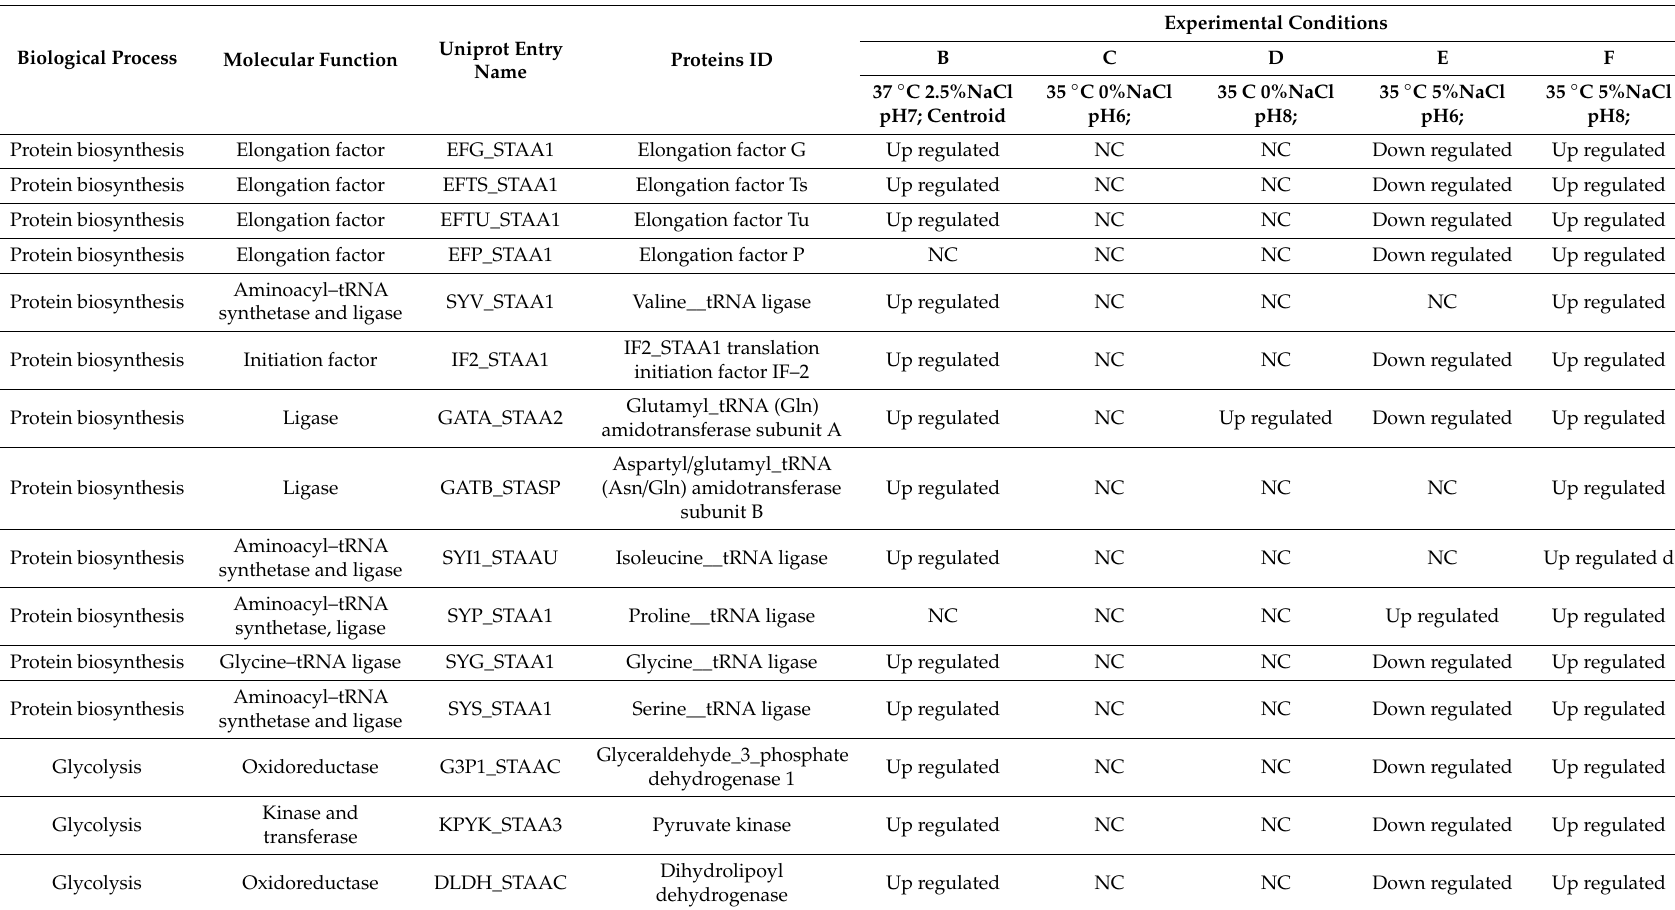
Table 1. Bacterial proteins di ff erentially regulated following the exposure to changing environmental conditions (B–E) in comparison to the reference control samples